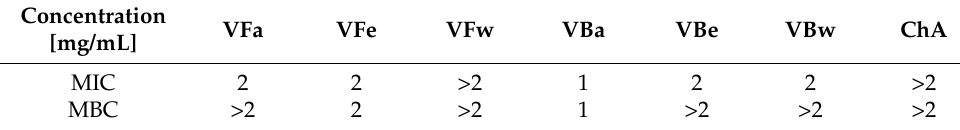
Table 2. MIC/MBC of the extracts from V. opulus fruits and bark, and activity of chlorogenic acid against S. aureus ATCC